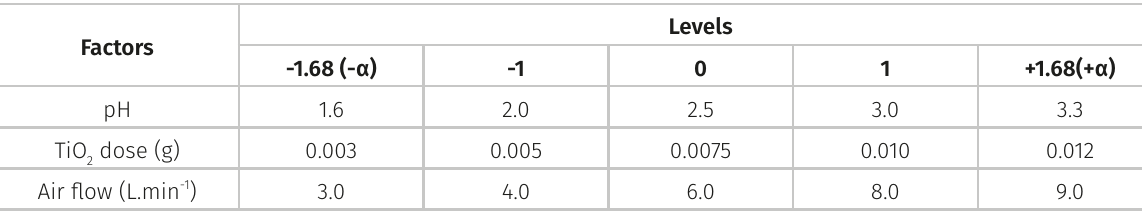
dose (g) and air flow 2